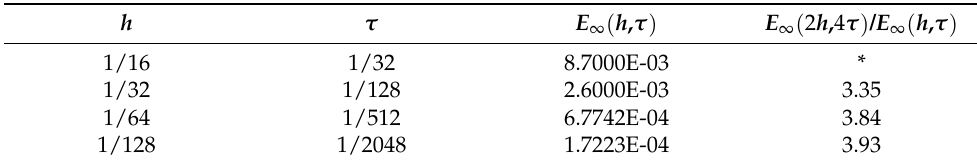
Table 2. The maximum error E ∞ ( h , τ ) corresponding to the asynchronous step length, where * means null.